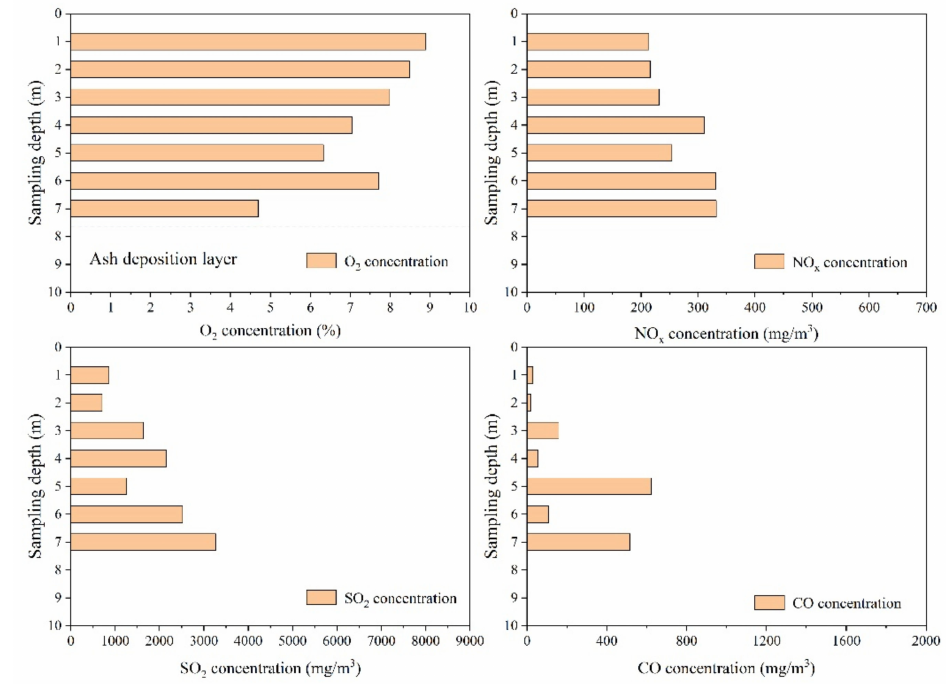
Figure 7. Vertical distributions of flue gas composition at the #B SNCR inlet.